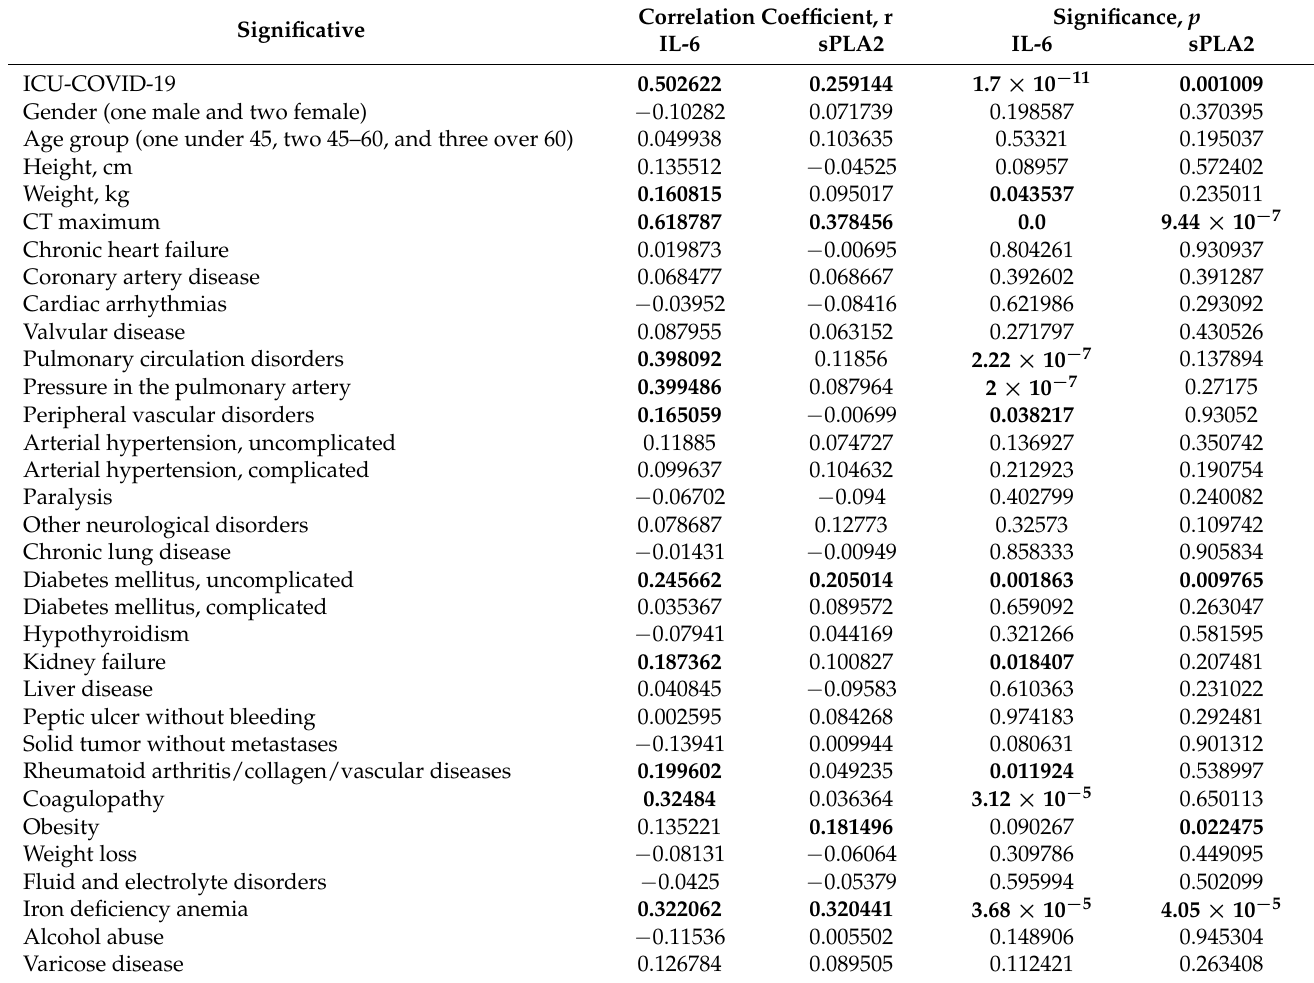
Table 4. Coefficients of correlations of IL-6, sPLA2, demographics, clinical parameters, and history of